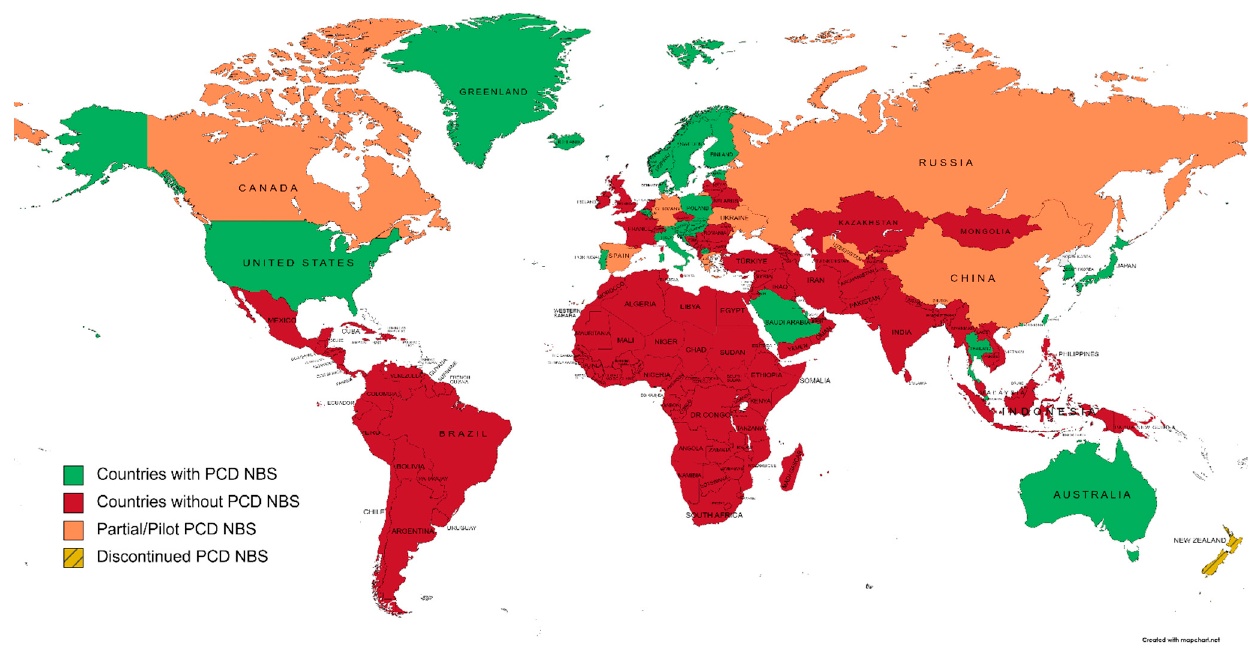
Figure 1. A world map of primary carnitine deficiency newborn screening programs, according to national NBS societies and the literature (created on mapchart.net, accessed on 27 October 2022).